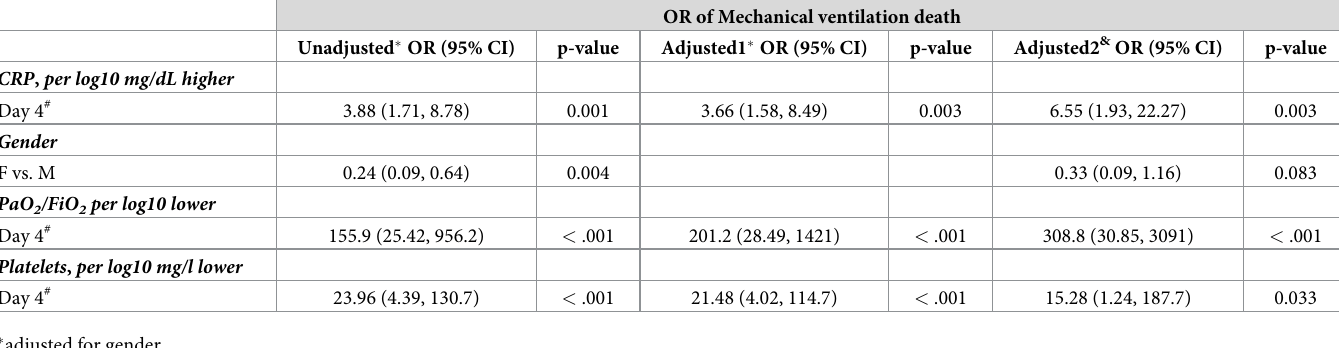
Table 2. OR from fitting a logistic regression